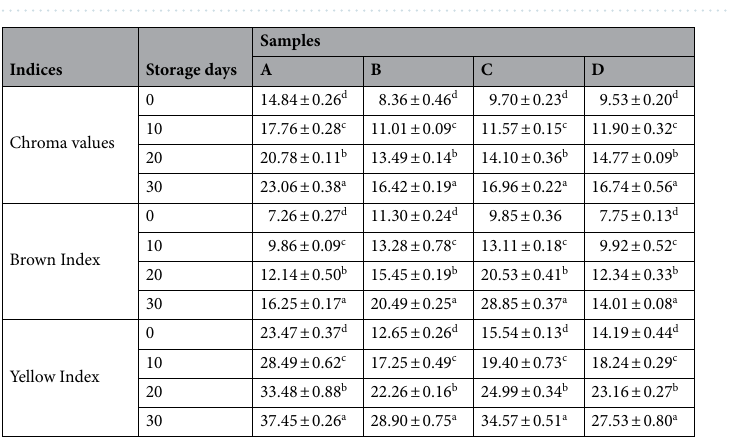
Figure 2. Images of yak butter powders sample A to D at day zero (represented by A0, B0, C0, and D0) and after 30 days of storage (represented by A30, B30, C30, and D30).